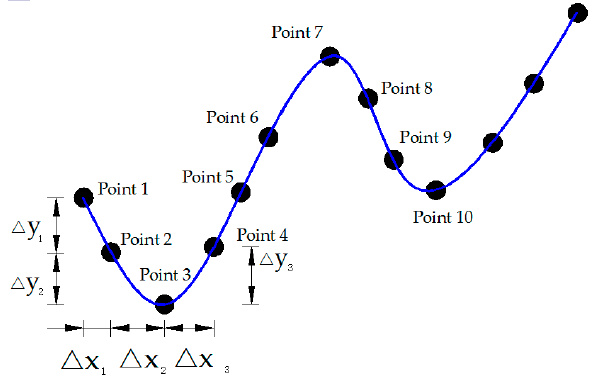
Figure 18. Discrete signal.